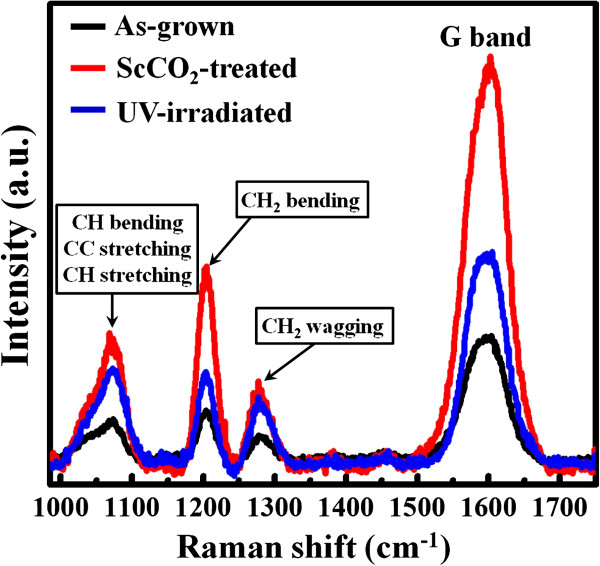
Raman spectra of as-grown 100-nm-diameter TiO2 nanotubes treated with ScCO2 fluid and subsequent UV light irradiation.